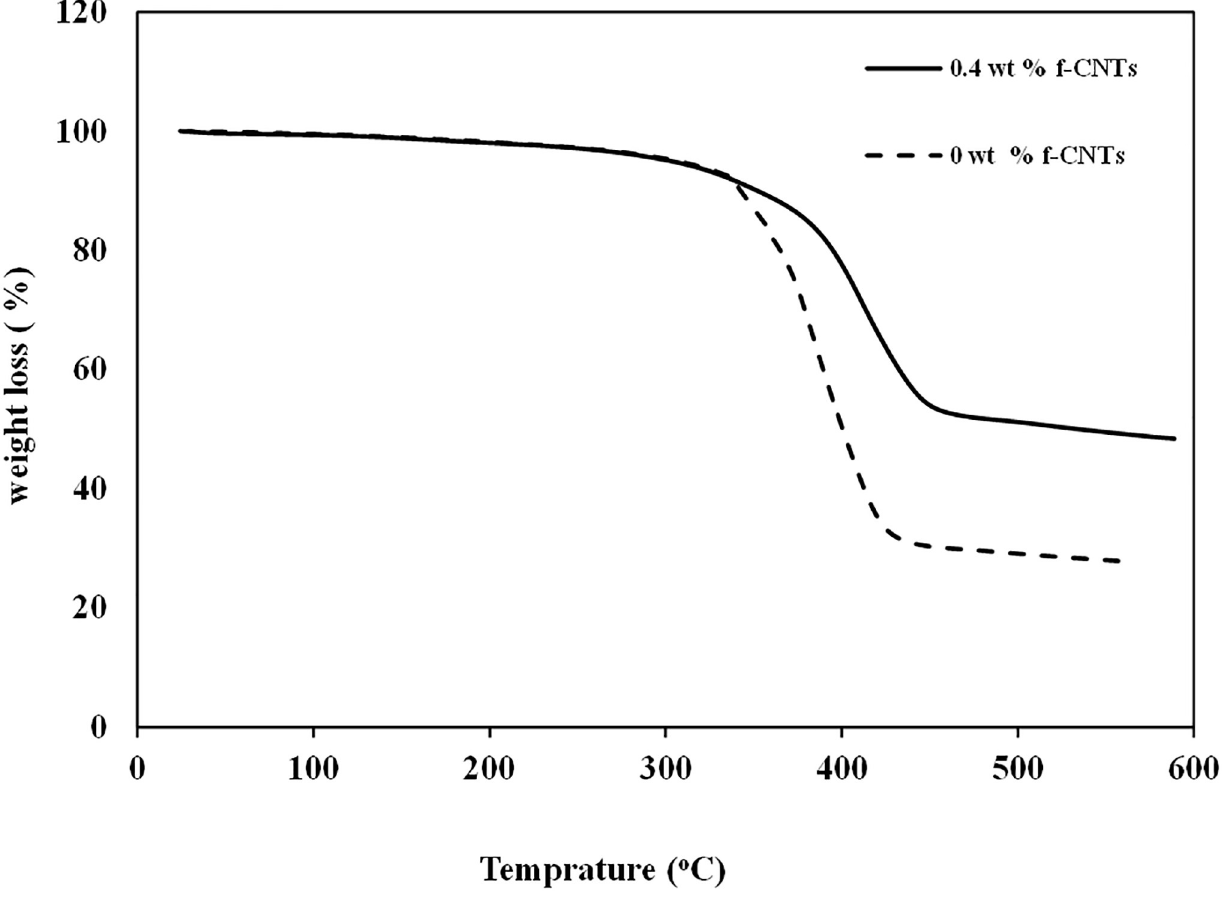
Fig 9. TGA for pure GFRPs and f-MWCNTs modified